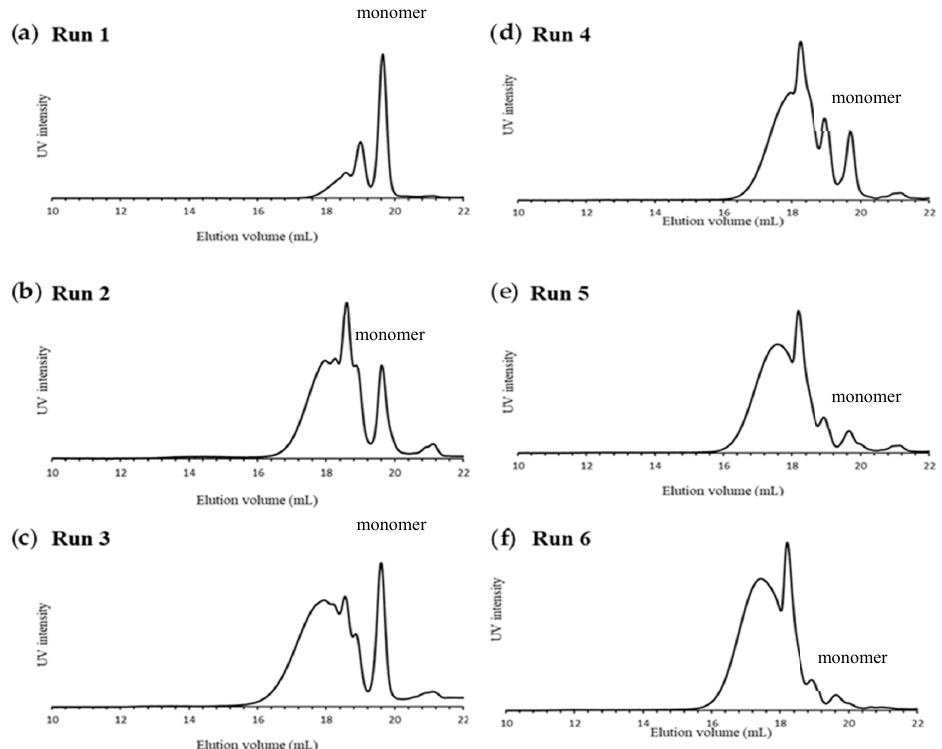
Figure 1. SEC UV traces of poly(oxindolidene thienylene vinylene) (POTV) samples ( a ) Run 1, ( b ) Run 2, ( c ) Run 3, ( d ) Run 4, ( e ) Run 5 and ( f ) Run 6.